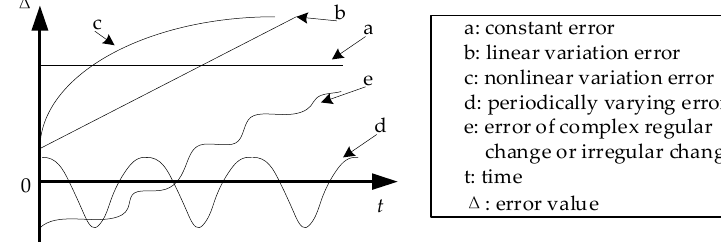
Figure 8. Different types of systematic errors.